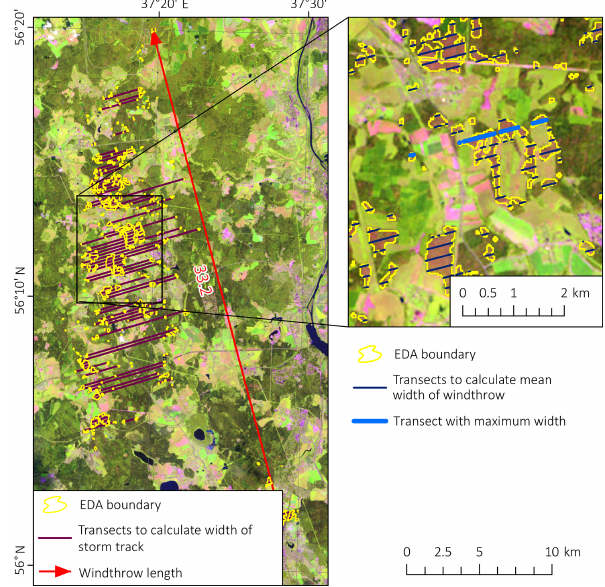
Figure 7. A scheme for the determination of the geometrical pa- rameters of a windthrow based on the Landsat image using the example of the windthrow in the Moscow region occurring on 21 June